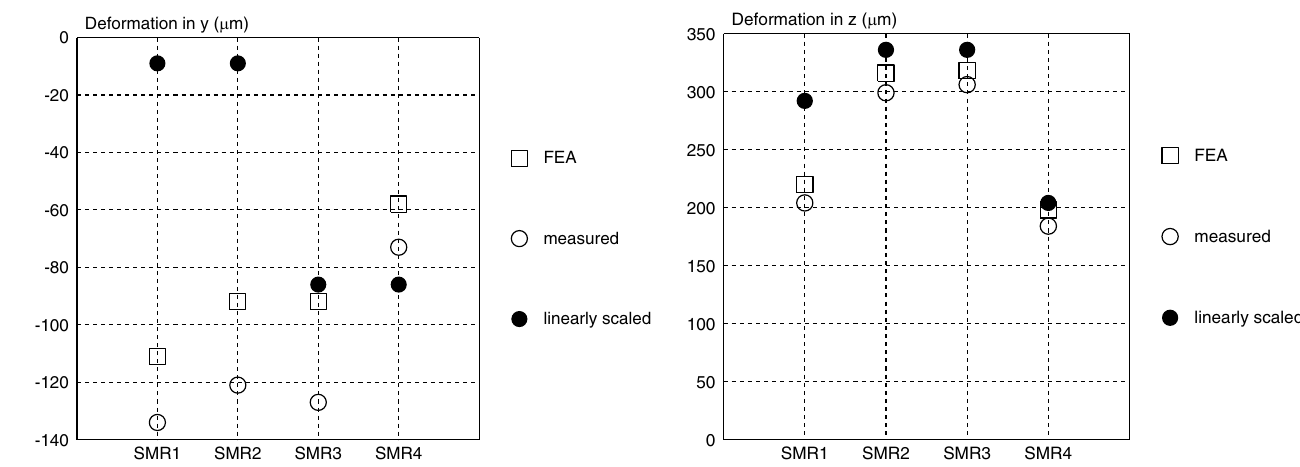
Fig. 9. Comparison of y -deformations. Fig. 10. Comparison of z -deformations.